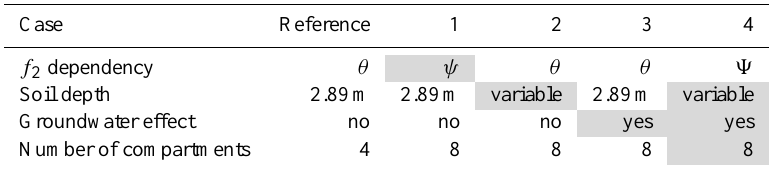
Table 3. Evaluated combinations of the modifications to HTESSEL. Four configurations (cases) were considered. The differences with respect to the reference HTESSEL is indicated in grey. f 2 dependency refers to the function used to calculate the effect of water stress. Soil depth refers to variable soil depth, groundwater effect refers to the considered effect of shallow groundwater and the number of compartments refers to the vertical discretisation of the soil column in HTESSEL.